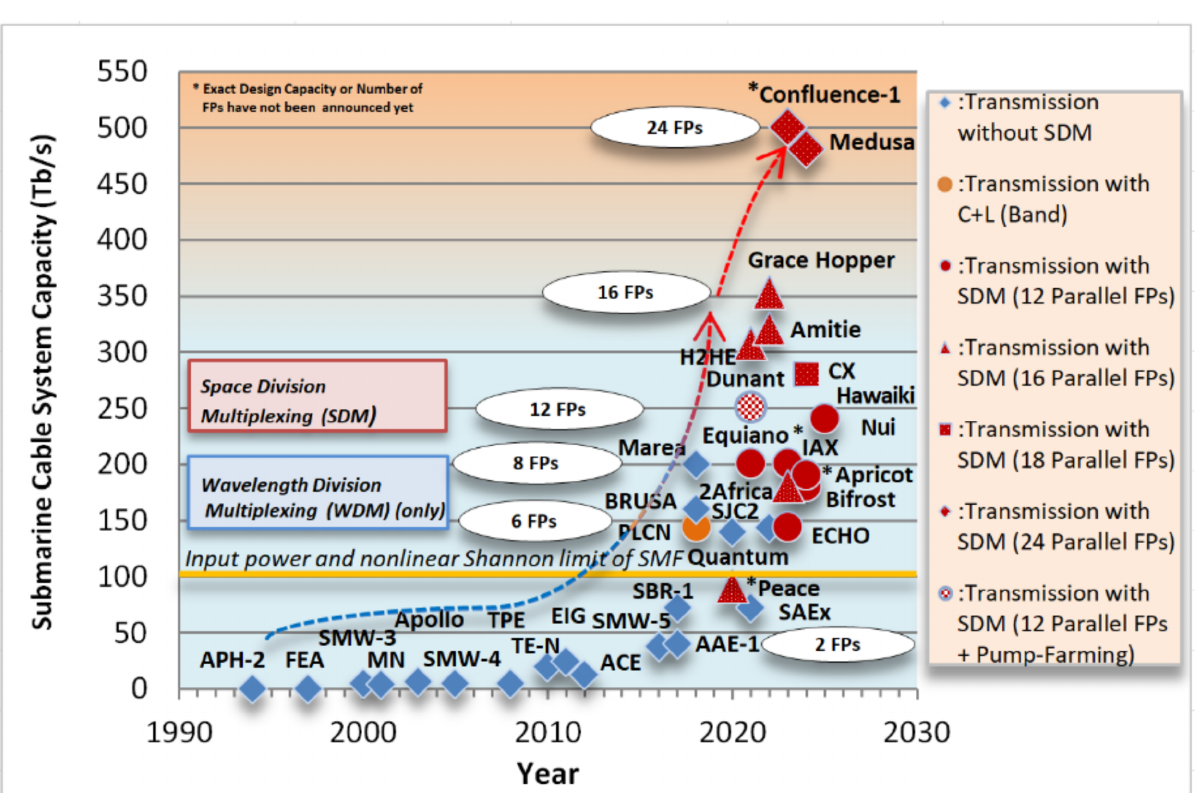
Figure 13. Evolution of submarine cable systems’ capacity through time (pre-SDM era vs. first- generation SDM